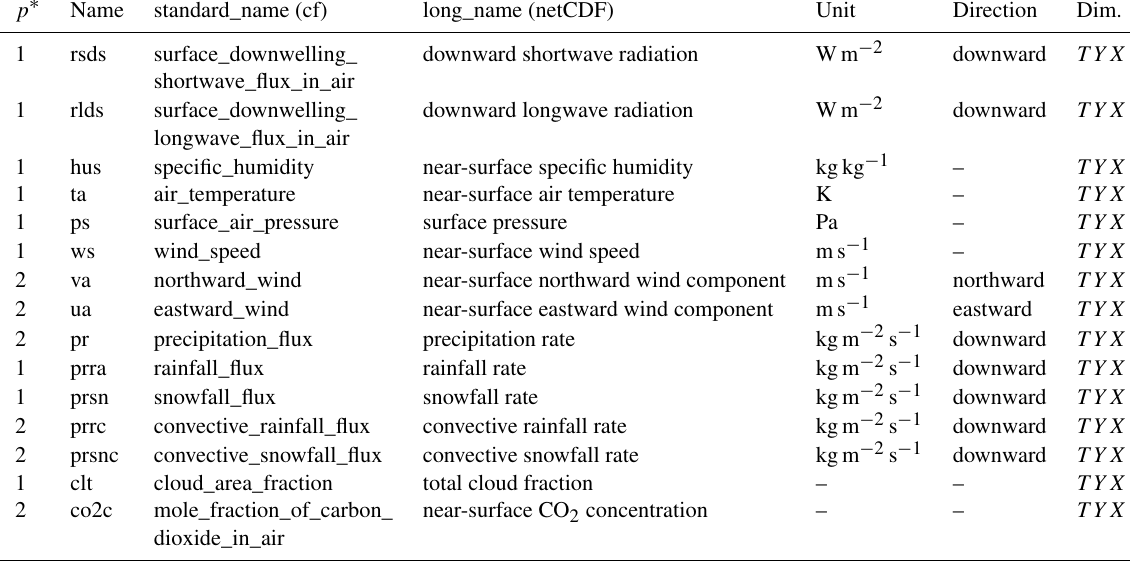
Table A4. Variable request table “L3hr”: 3-hourly variables to generate the atmospheric boundary conditions for the off-line